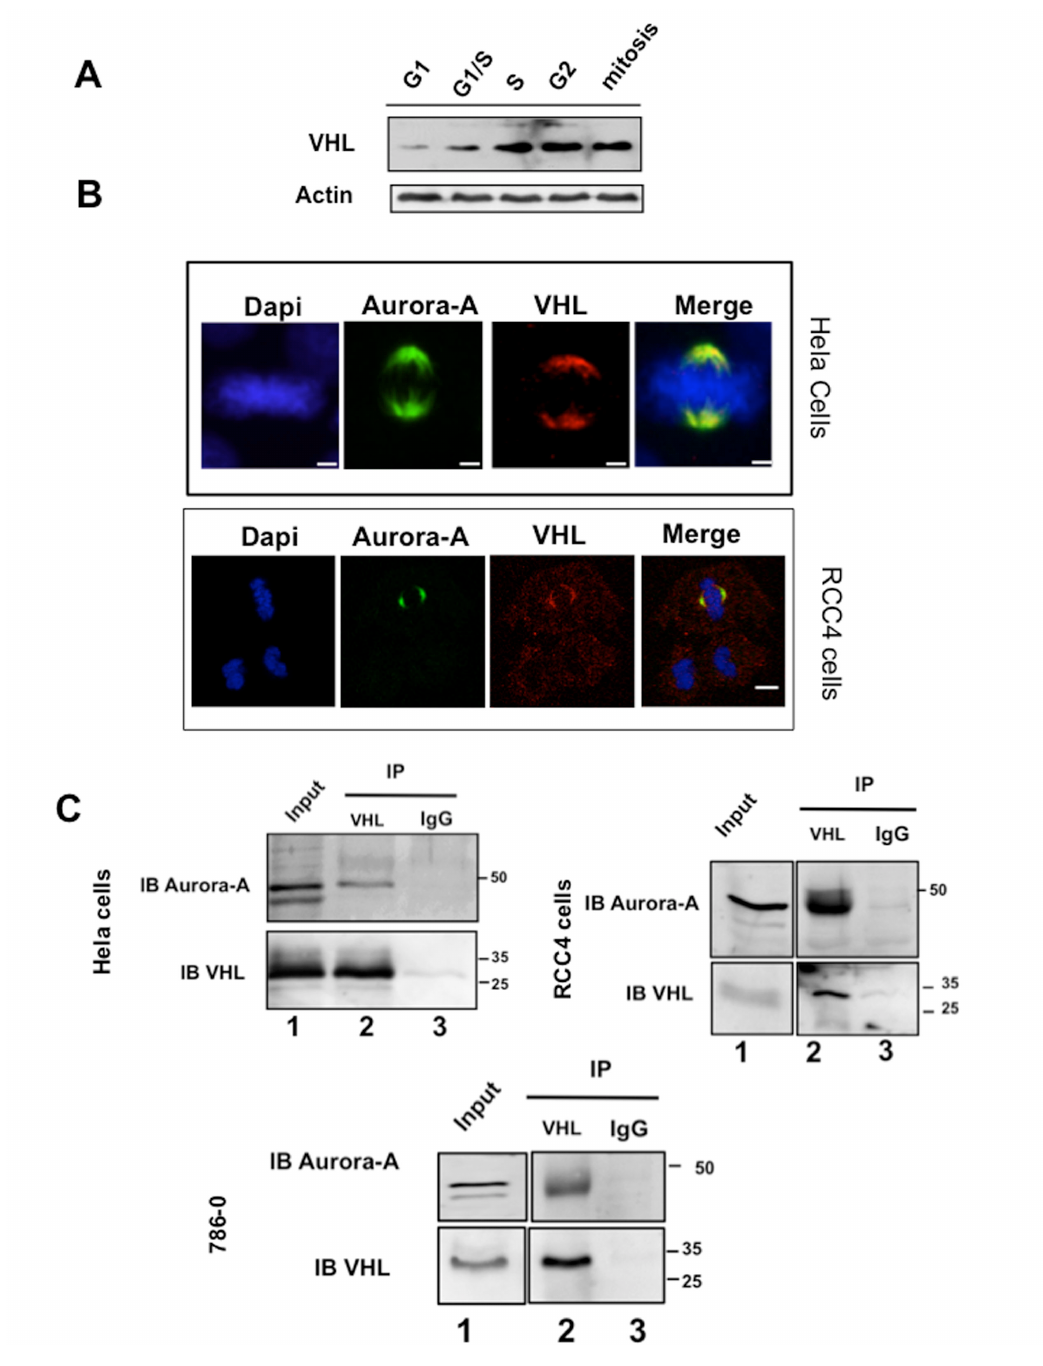
Figure 4. pVHL interacts with Aurora-A. A-HeLa cells were synchronized as described in Materials and Methods. Twenty µg of protein extracts were separated on a poly-acrylamide gel and VHL expression was assessed with the monoclonal anti-pVHL antibody (1:200). Loading was controlled with the anti-Actin antibody (1:200). B-In HeLa and RCC4 cells, Aurora-A and VHL co-localize at the centrosome and at the mitotic spindle extremities (anti-Aurora-A antibody, 1:200 and anti-pVHL antibody, 1:200). C-HeLa, RCC4 and 786-0 cell protein extracts were immunoprecipitated with the anti-pVHL polyclonal antibody (lane 2) or with the IgG (lane 3, negative control). Aurora-A and pVHL were both detected in the immunoprecipitates using a polyclonal antibody against Aurora-A (1:200) (upper panel) and a monoclonal antibody against pVHL (1:200) (lower panel). Lane 1 was corresponding to the total cell extract. doi: 10.1371/journal.pone.0067071.g004 PLOS ONE |